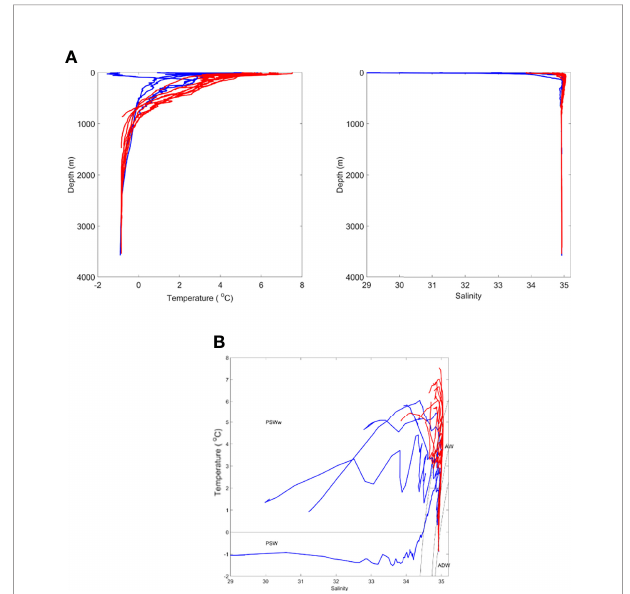
FIGURE 2 | Oceanographic conditions during time of sampling showing (A) temperature and salinity pro fi les and (B) TS plot [divided into two oceanographic zones. denoting Western Fram Strait (WFS; blue) and Eastern Fram Strait (EFS; red)]. PSWw - Polar Surface Water (warm) due to solar heating. See text for all other